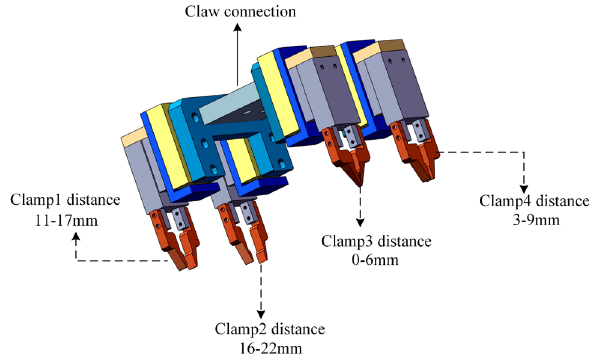
Figure 5. Robot’s flexible multi-gripper claw construction.